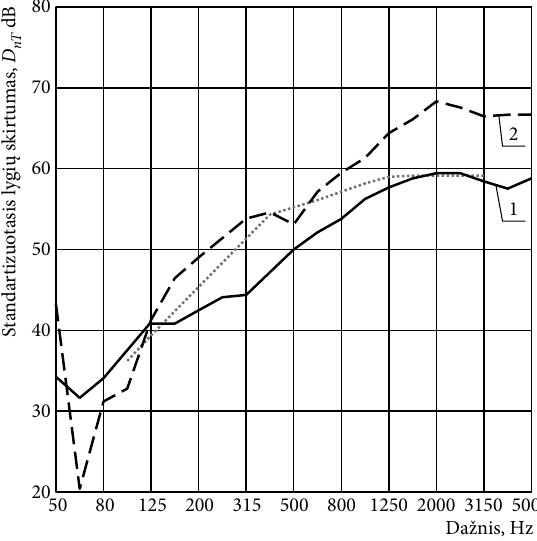
Table 1. The values of single parameter indicators of airborne sound insulation for wall construction